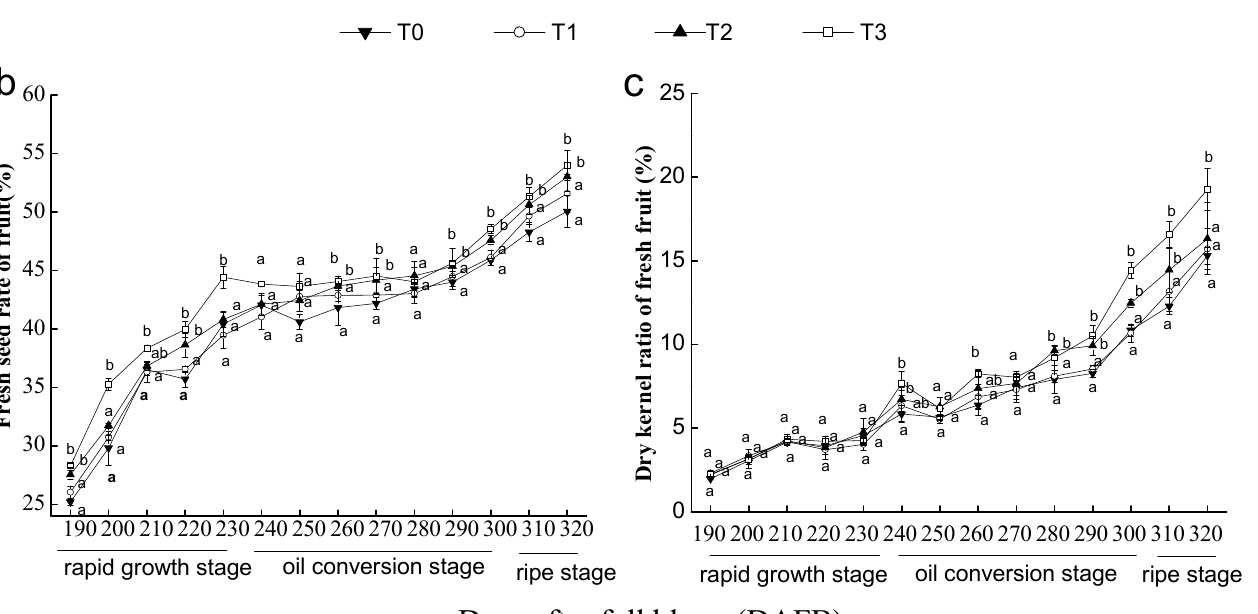
ripe stage ripe stageoil conversion stageoil conversion stage rapid growth stagerapid growth stage